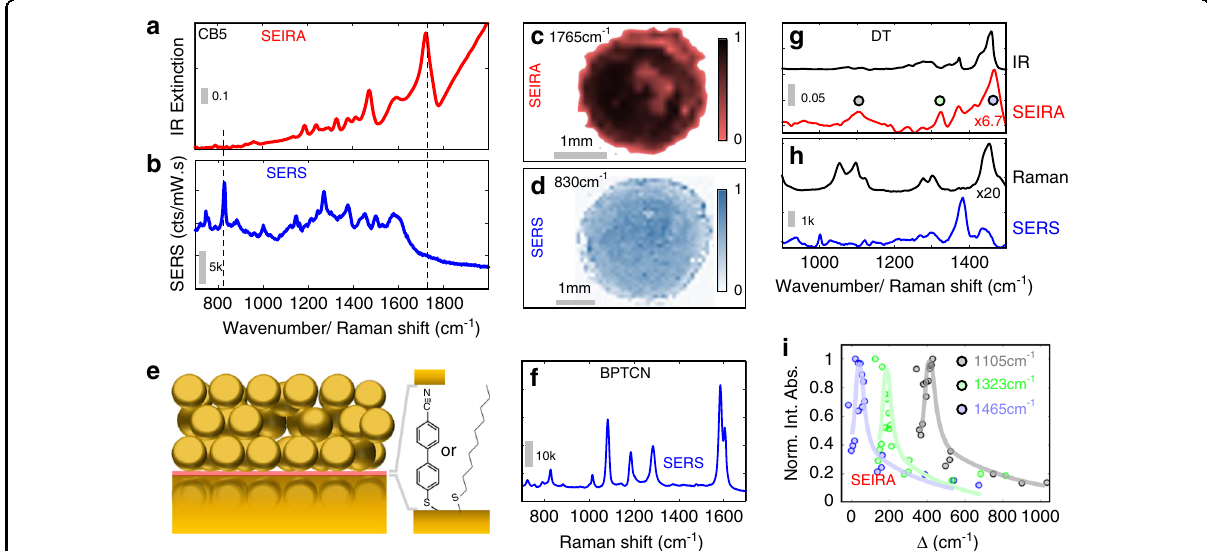
Fig. 4 Comparison of SERS and SEIRA. a FTIR re fl ectance spectrum (in wavenumbers) and b SERS spectrum (in Raman shift, λ exc = 785 nm), of NP7ML-on-mirror fi lms ( D = 100 nm). c , d Simultaneous SERS and SEIRA measurements on NP7ML fi lms ( D = 100 nm): c SEIRA map of CB[5] C = O stretch (1765 cm − 1 ), d SERS map of CB[5] ring deformation (830 cm − 1 ) (normalized peak areas). e Schematic of NP3ML-on-mirror fi lm with self- assembled monolayer of 4 ′ -cyanobiphenyl-4-thiol (BPTCN) or decane-1-thiol (DT) in the mirror gap (red), with f BPTCN SERS spectrum. g , h SEIRA and SERS of monolayer DT in NP7ML-on-mirror fi lms compared to reference liquid IR/Raman spectra 50 . All spectra are background corrected (details in SI Section S10), gray bars give counts/mW.sec for Raman/SERS and absorbance for IR/SEIRA. Labels on SEIRA and Raman spectra indicate intensity scaling. i Integrated IR absorbance for DT modes at 1105 cm − 1 (integrated from 1050 – 1150 cm − 1 ), 1323 cm − 1 (1300 – 1340 cm − 1 ), and 1465 cm − 1 (1450 – 1600 cm − 1 ) vs detuning of plasmon mode from each vibration (normalized, lines are guides to the